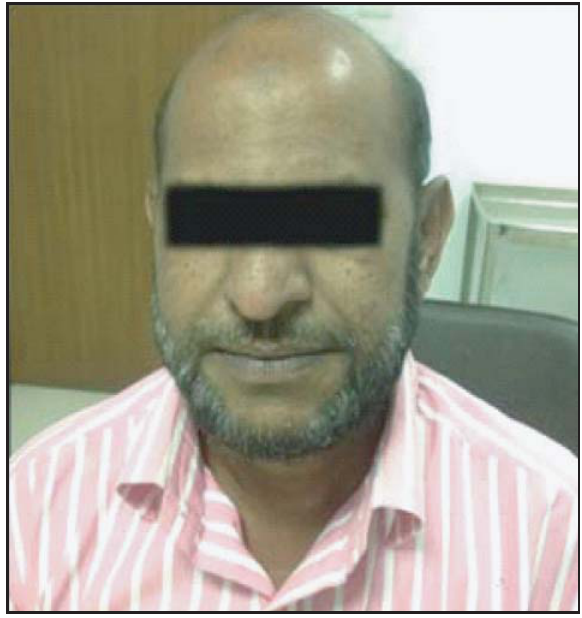
Fig 3. Face after improvement of pigmentation Fig 4. Hands after improvement of